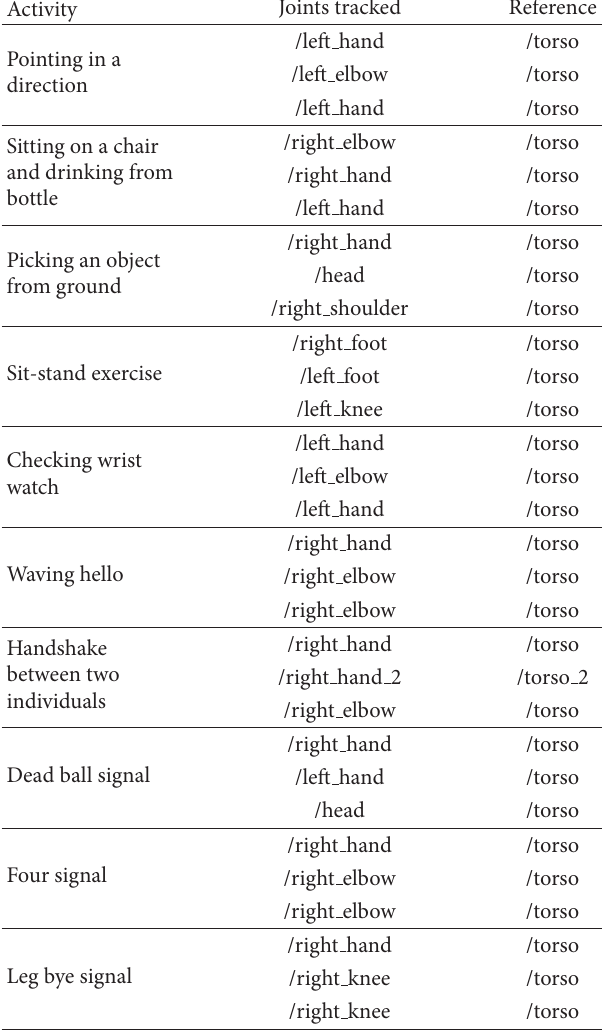
Table 1: The summary of the joints and their reference points used during manual selection of subset joints where the /right hand 2 shows the right hand of second user during handshake